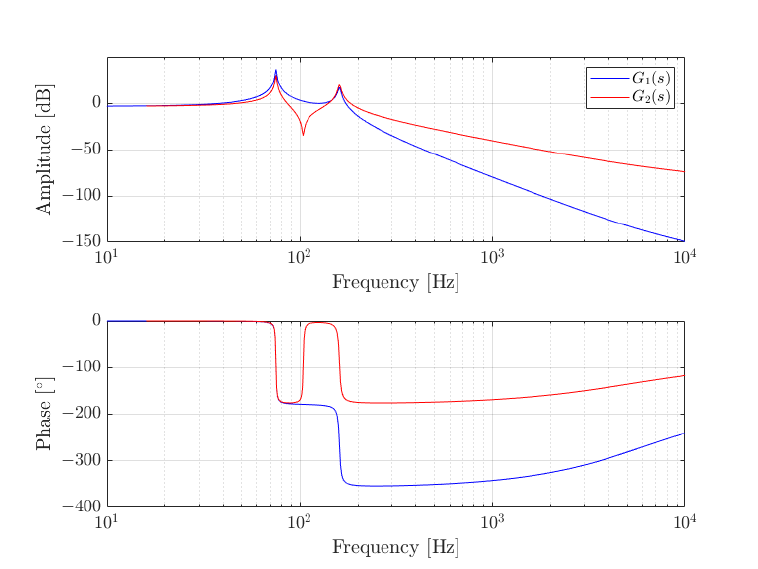
Figure 9. Bode plot of transfer functions G 1 ( s ) and G 2 ( s )